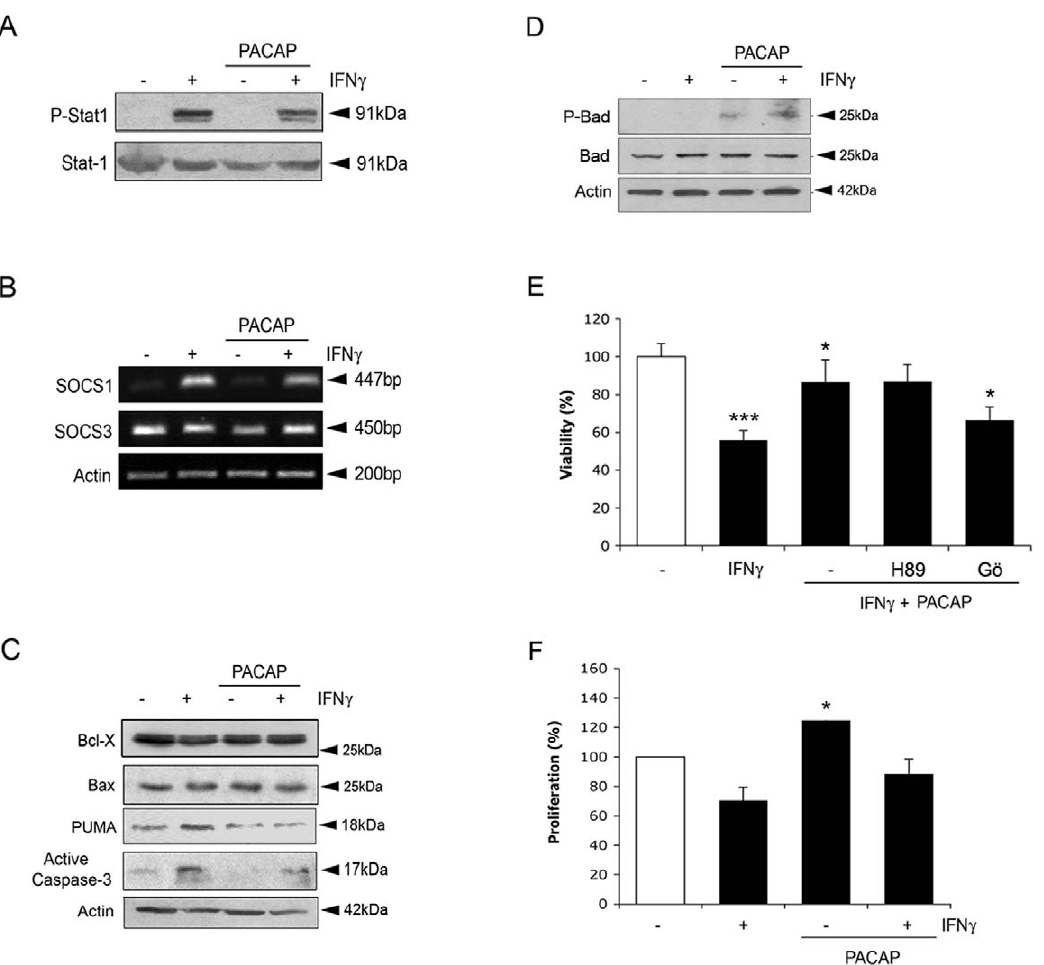
Figure 6. Effect of PACAP on NPCs. NPCs were treated for 24 h with 100 ng/ml IFN c alone or in conjunction with 100 ng/ml PACAP. ( A ) Immunoblot. Cells were treated for 2 h. PACAP did not influence levels of p-Stat1 induced by IFN c . ( B ) RT-PCR. SOCS-1 and –3 levels are not influenced by PACAP. IFN c upregulated SOCS1. ( C ) Immunoblots. IFN c increased whilst PACAP decreased levels of PUMA. PACAP also decreased active caspase-3 (17 kDa band). Typical blot is shown and was repeated three times. ( D ) Immunoblots. PACAP increased levels of p-Bad. Typical blot is shown and was repeated three times. ( E ) Effects of the kinase inhibitors on cell viability measured by MTT. 1 m M Go¨6976 reduced the beneficial effect of PACAP whereas 10 m M H89 had no effect. Values are means 6 SD, n=4. *** p , 0.005 for IFN c vs. controls, and *p , 0.0 for IFN c + PACAP vs. IFN c , and for GO¨ + IFN c + PACAP vs. IFN c + PACAP. ( F ) BrdU labeling. PACAP increases cell proliferation significantly in control but not in IFN c treated cells. Values are means 6 SD, n=4. * p , 0.05 for PACAP vs control cells,